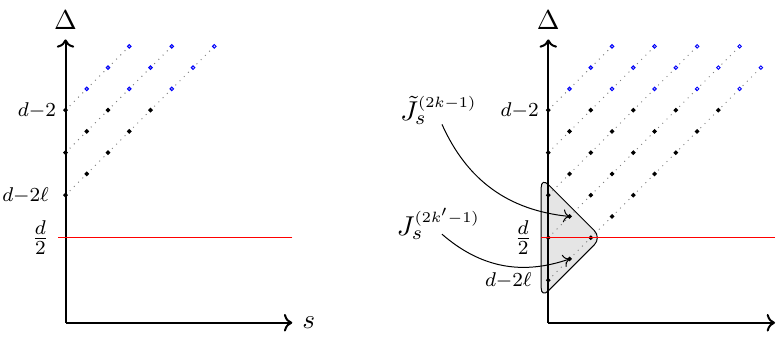
Figure 1 . The spectrum of bilinear operators, labeled by ((cid:1) ; s ) , of the order- ‘ scalar CFT is depicted. The black solid circles and the blue empty circles designate respectively the operators without conservation condition and with (partial-)conservation condition. The number of the dotted lines is ‘ . The left diagram is the case with ‘ < d operators in the shaded region do not give rise to on-shell FT